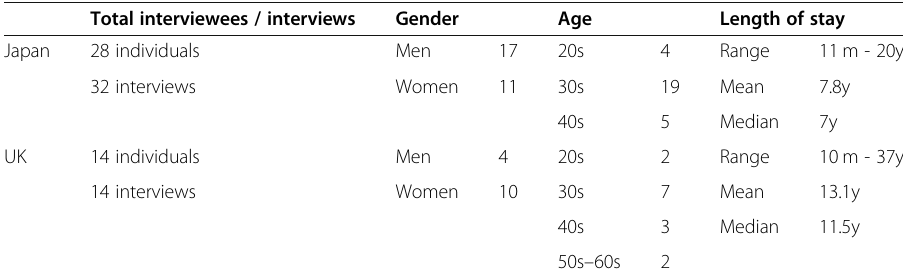
Table 1 Sample characteristics for the Japan and UK case